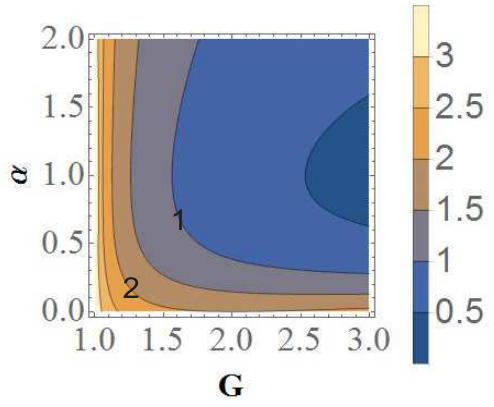
Figure 5. The dependence of V s 12 in Equation (18).